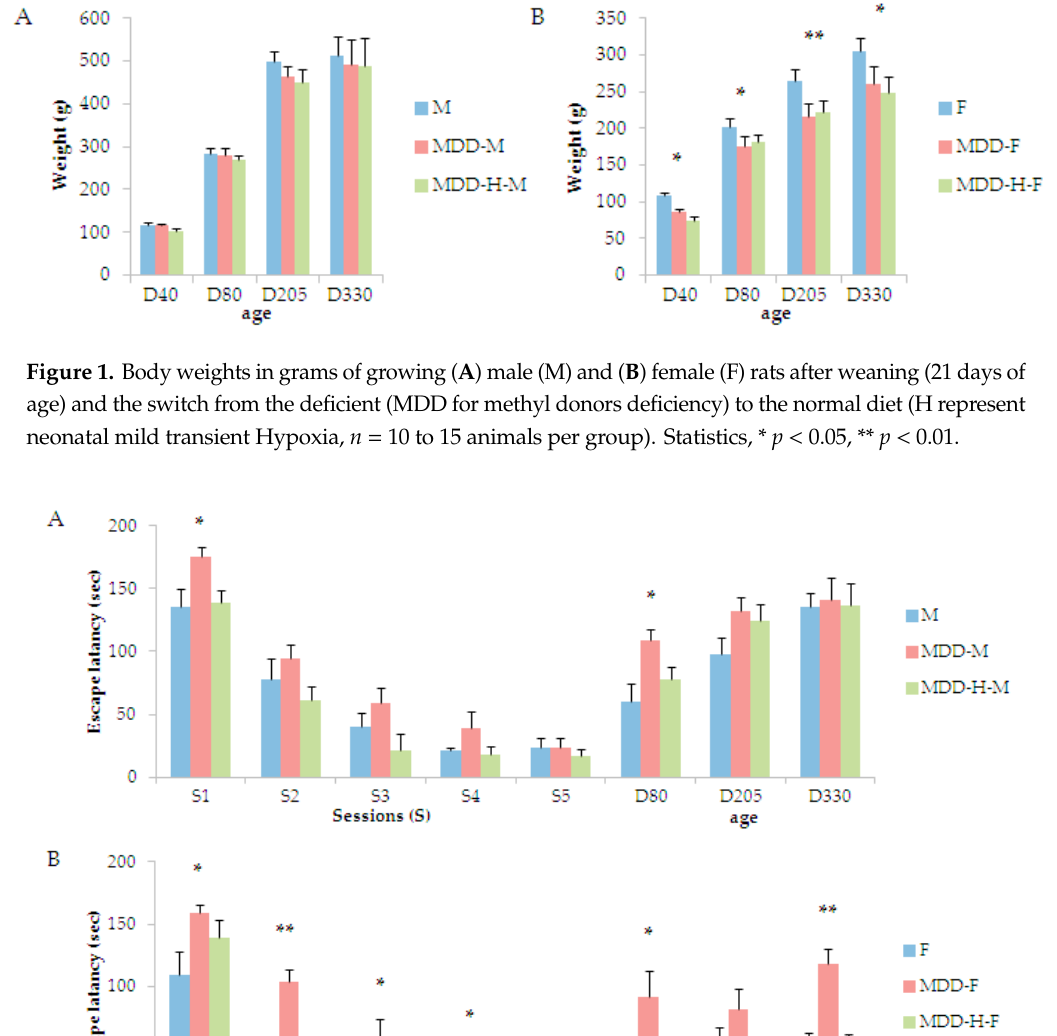
Figure 1. Body weights in grams of growing ( A ) male (M) and ( B ) female (F) rats after weaning (21 days of age) and the switch from the deficient (MDD for methyl donors deficiency) to the normal diet (H represent neonatal mild transient Hypoxia, n = 10 to 15 animals per group). Statistics, * p < 0.05, ** p < 0.01.